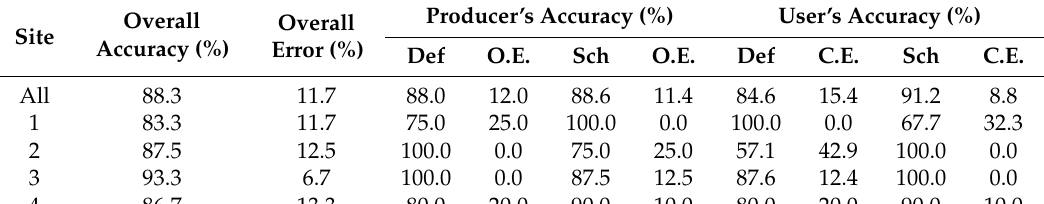
Table 2. Accuracy analysis results from change detection, represented by overall accuracy and its complementary measure, overall error; producer’s accuracy and its complementary measure omission error (O.E.); and user’s accuracy and its complementary measure commission error (C.E.).